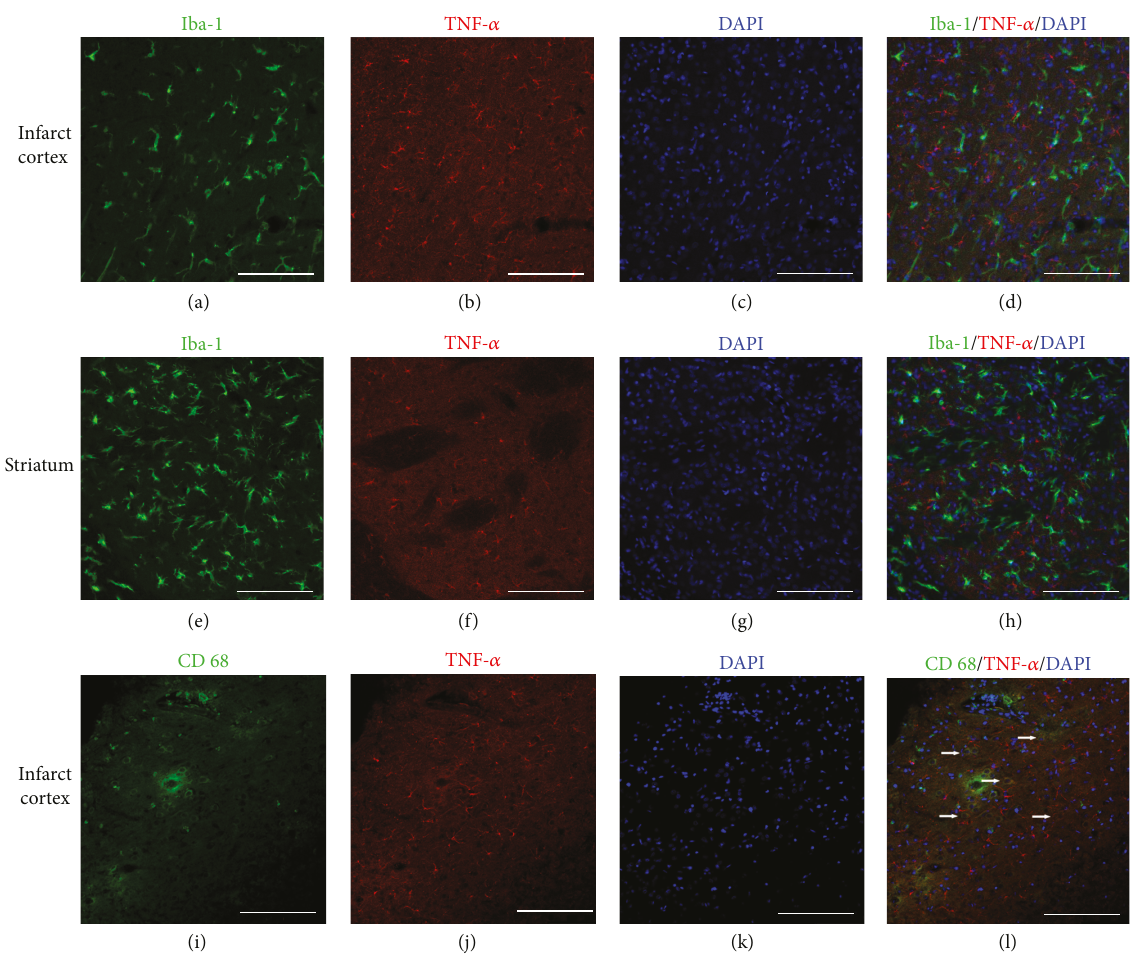
Figure 6: CD68 + microglia but not Iba-1 + cells express TNF- α in the ischemia ipsilateral hemisphere at day 2. (a – d) Distribution of Iba-1 + and TNF- α + cells in the infarct areas after MSC transplantation. (e – h) Distribution of Iba-1 + and TNF- α + cells in the striatum after MSC transplantation. (i – l) Distribution of CD68 + and TNF- α + cells in the infarct areas after MSC transplantation. (a, e) Iba-1 staining. (i) CD68 staining. (b, f, j) TNF- α . (c, g, k) DAPI nucleus staining. (d) No double-stained Iba-1 + /TNF- α + cells were found in the infarct area after dMCAO. (h) No Iba-1+/TNF- α cells was found 2 days after MSC transplantation in the striatum. (l) Some CD68 + cells in the infarct areas were positive for TNF- α . Arrow: double-labeled cells. Scale bar, 250 μ